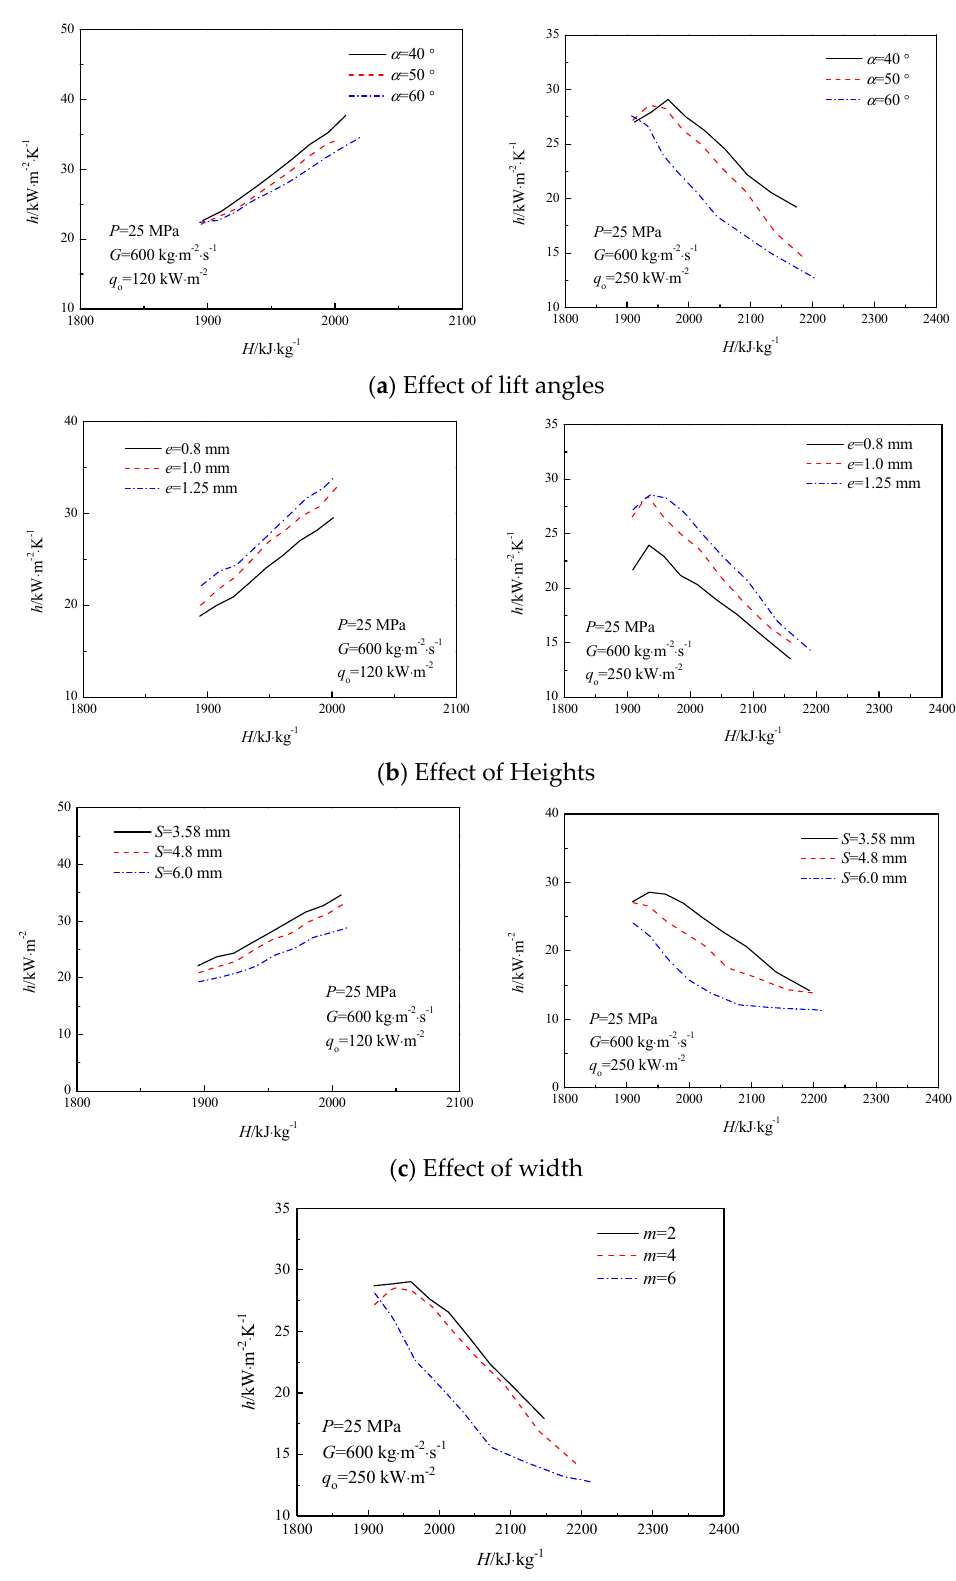
Figure 12. Effects of rib parameters on heat transfer of supercritical water.